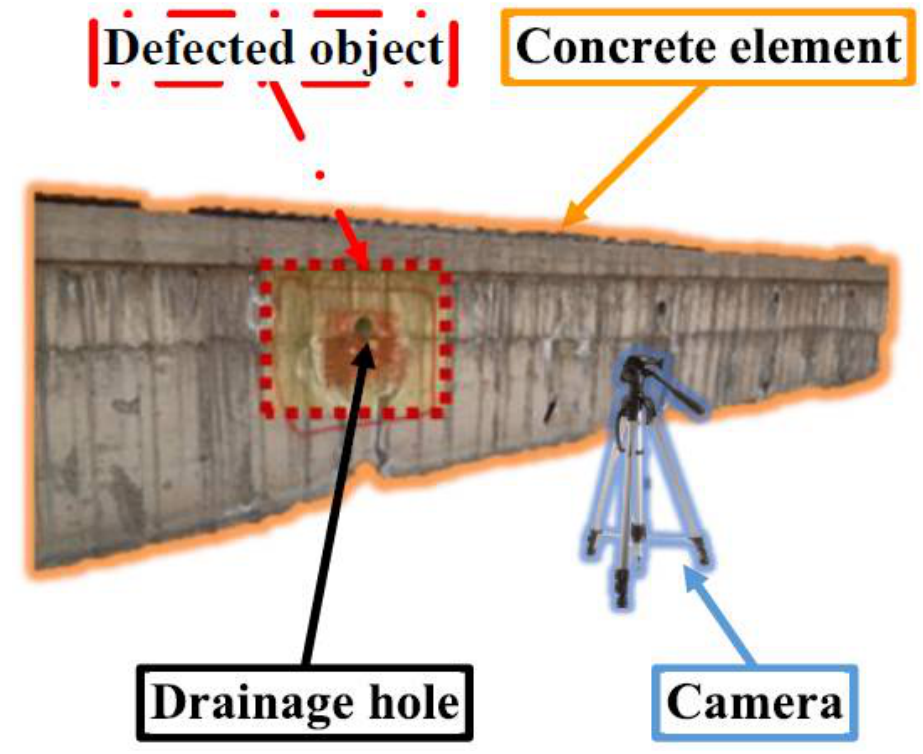
Figure 4. Case study subject–RC element.